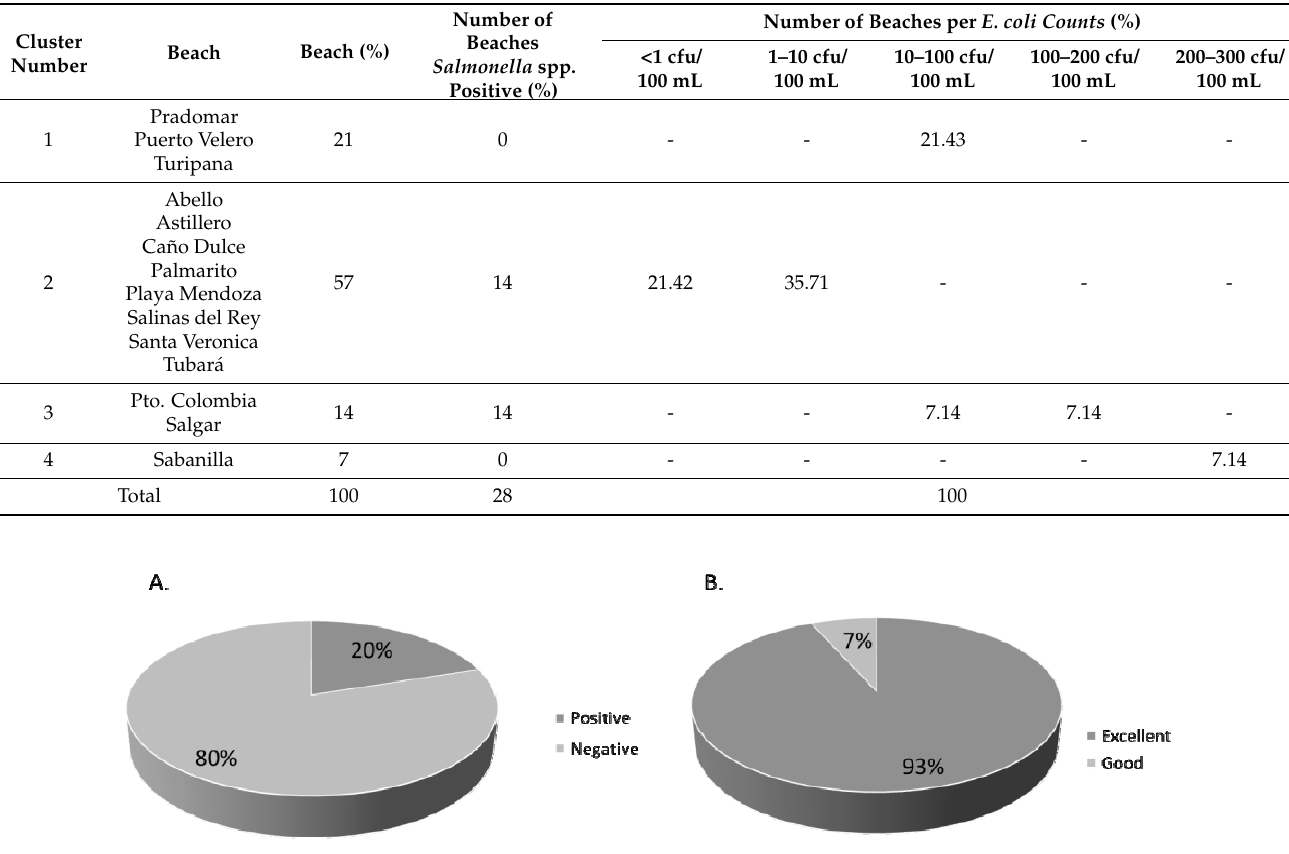
Figure 2. Pie chart of percentage of samples positive and negative for Salmonella spp. detection ( A ), percentage of samples complying Directive 2006/7/EC regarding E. coli concentration in seawater ( B ).